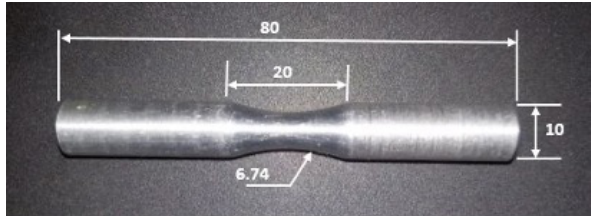
Figure 3: Fatigue specimen (all dimensions in mm)